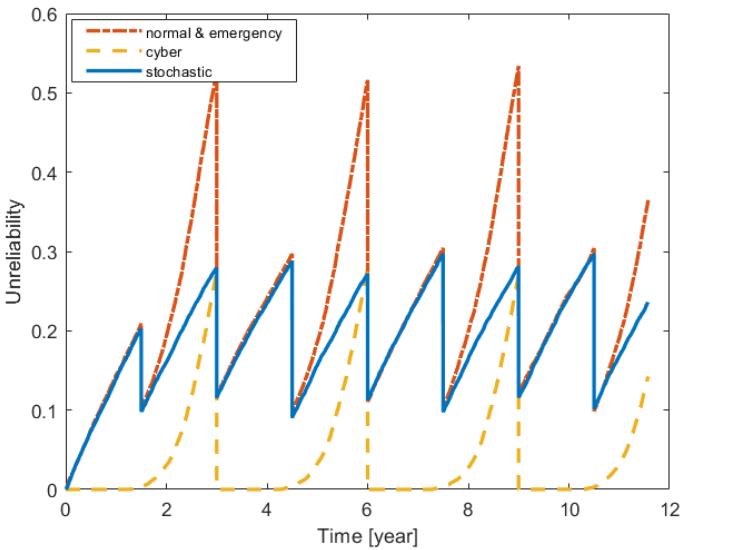
Figure 11. Result of system unreliability under the emergency condition.